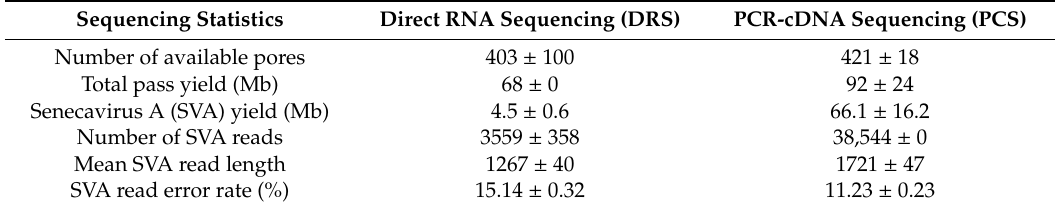
Table 1. A comparison between the sequencing statistics of the direct RNA and PCR-cDNA methods after 6 h sequencing *.